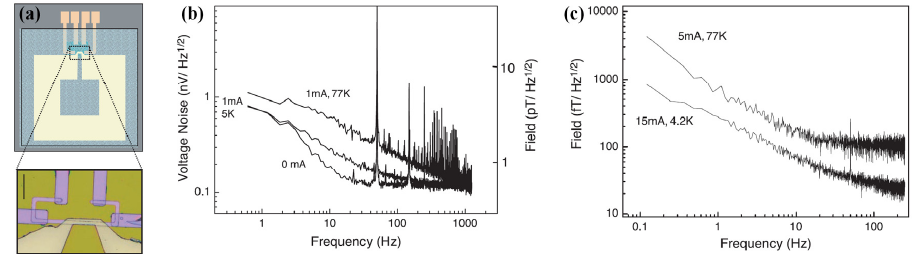
Figure 12. ( a ) Schematic view of the integrated device, comprising a GMR sensor with a